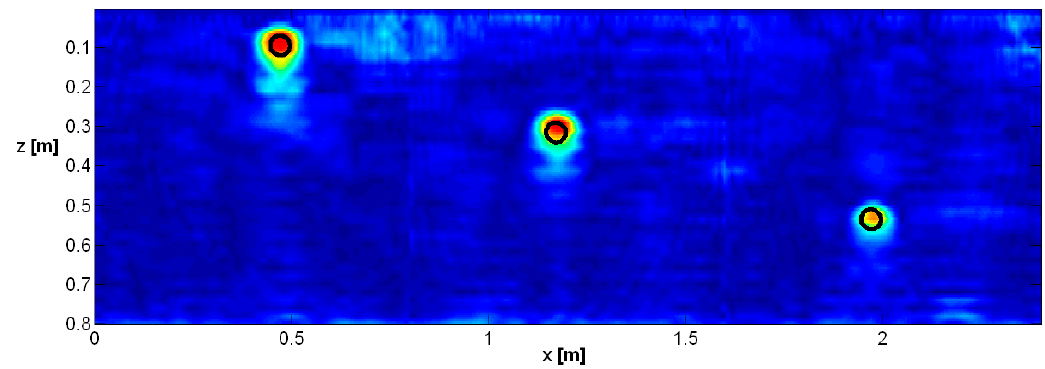
Figure 8. The experimental radar data, in time domains, after free-space response removal ( a ), and after further ( b ) zero timing and background removal. In the lower image, a time cut has also been done, in order to focus on the depth range of interest.